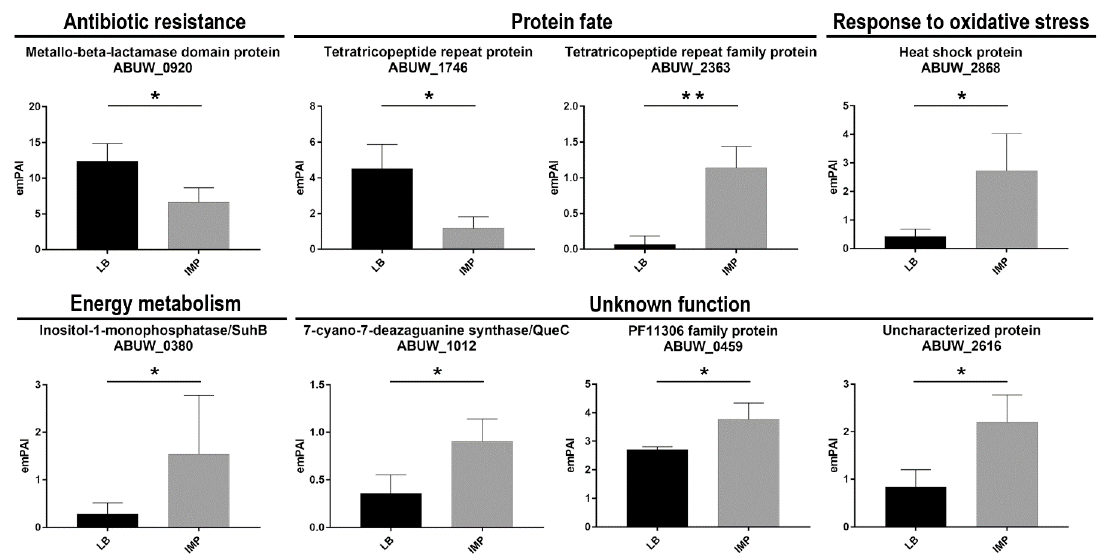
Figure 5. Semi-quantitative analysis of differentially expressed periplasmic proteins from strain AB5075 grown in LB or LB supplemented with IMP. The data are the means ± standard deviation from three independent experiments. The functional categories of periplasmic proteins identified assigned as previously described are shown. The emPAI and statistical significance values are shown. Asterisks represent p values evaluated by t test; ** p < 0.01, * p < 0.05.